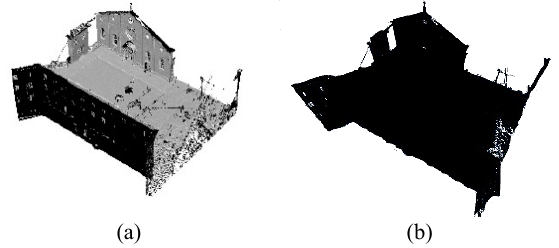
Figure 5. a) Point cloud with Normals displayed inside CloudCompare. b) The same point cloud displayed in Holoverse Present.